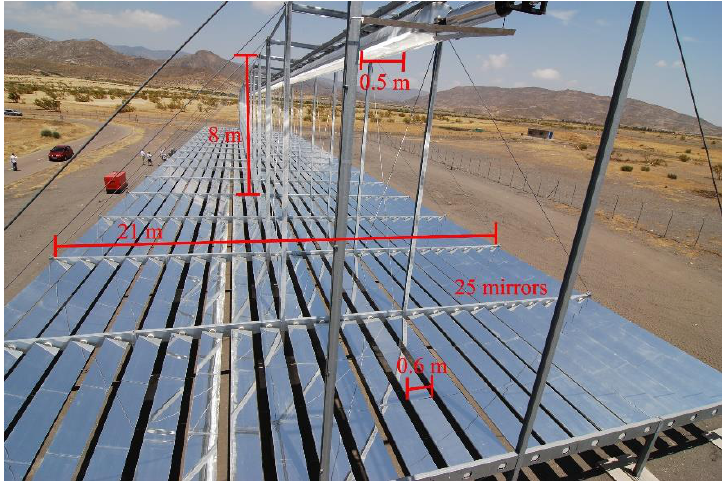
Figure 3. Angles in a LFR: ( a ) Determination of the transverse solar altitude angle; ( b ) Determination of the incidence angles. Figure 4. Main geometrical parameters of the FRESDEMO prototype [24].